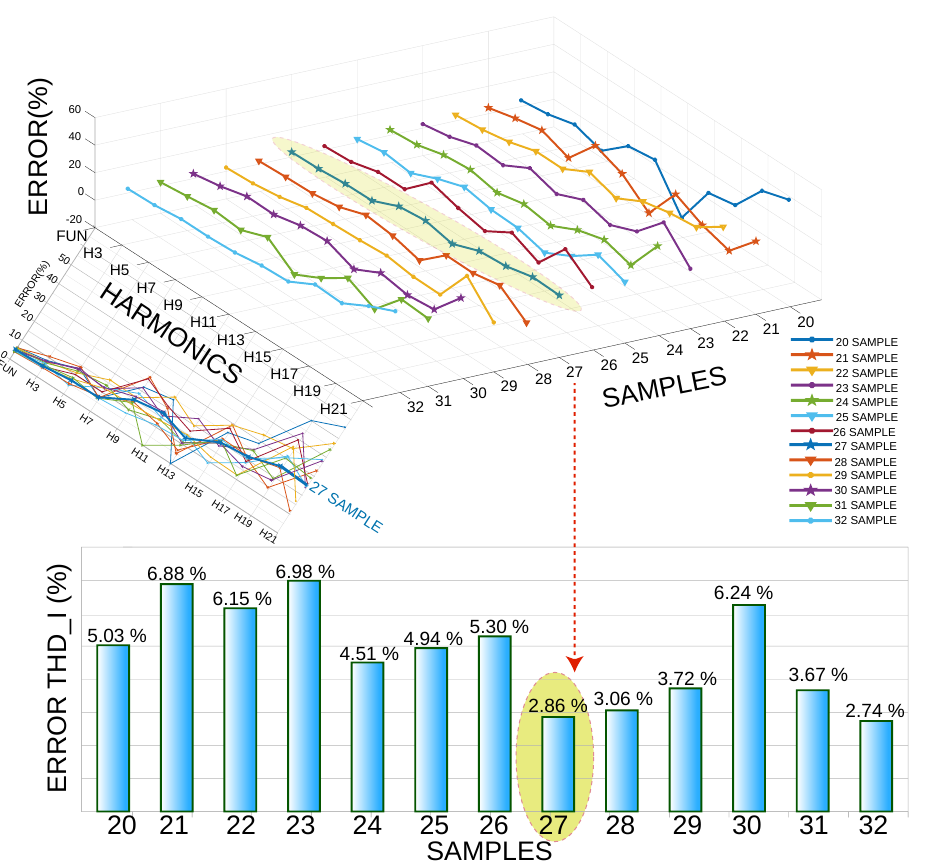
Figure 13. Error vs. harmonics, keeping the number of periods constant at 20 and varying the number of samples per cycle from 20 to 32.